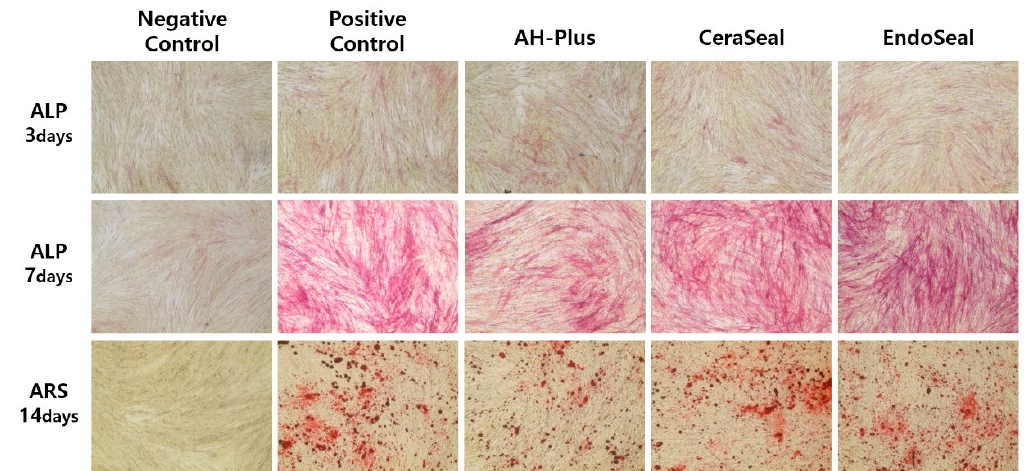
Figure 5. The effects of sealers on the osteogenic differentiation of hPDLSCs. The 40× magnified microscope images are shown. Negative control, cultured in normal culture media; Positive control, cultured in osteoinduction media (normal culture media with osteogenic-inducing reagents); Experimental groups, cultured in setting media with osteogenic-inducing reagents.